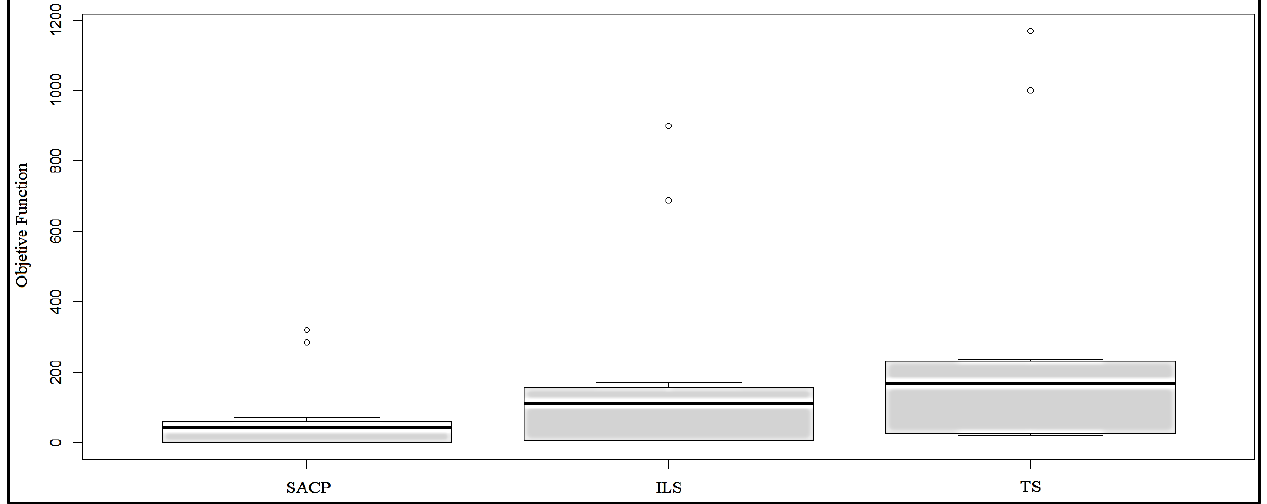
Figure 11. Boxplot of the SACP, ILS and TS algorithms.